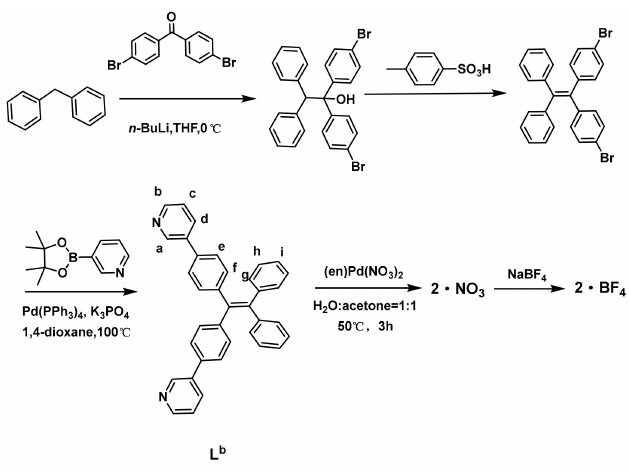
Scheme 3. Synthetic procedures of ligand L b and assembly 2